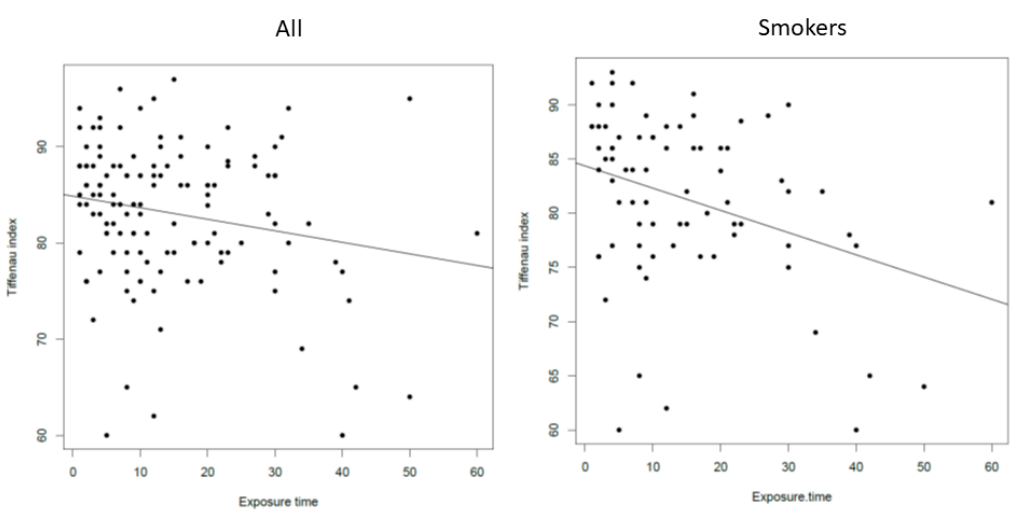
Figure 5. On the left, the correlation between Ti ff eneau index (FEV1 / FVC) and exposure time for all the bakers studied ( p = 0.02, r = − 0.20); on the right, the correlation between Ti ff eneau index (FEV1 / FVC) and exposure time for the bakers who were smokers ( p = 0.002, r = − 0.34).